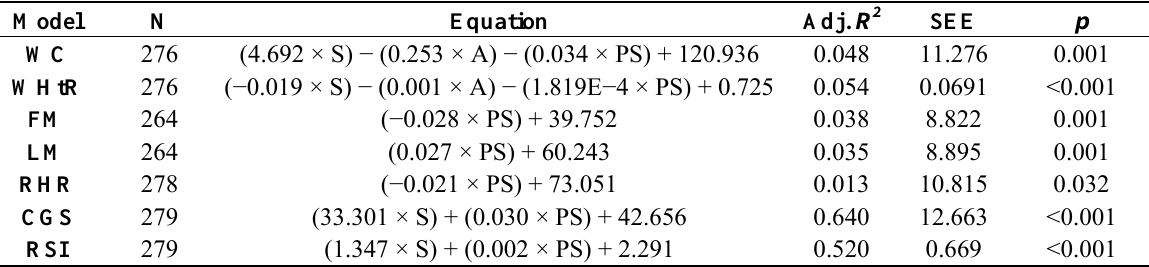
Table 5. ( All participant data. Significant ( p < 0.05) regression models combining sex (S: 0 = female, 1 = male), age (A; year), and PASE score (PS) to predict WC (cm),